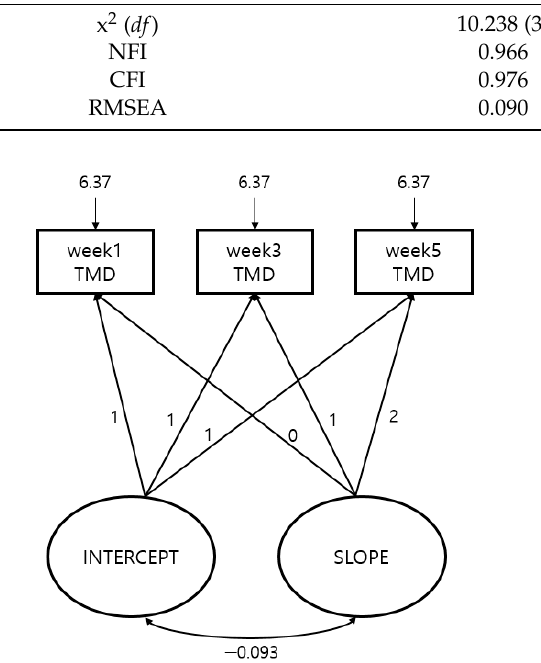
Figure 2. Latent growth model of TMD.